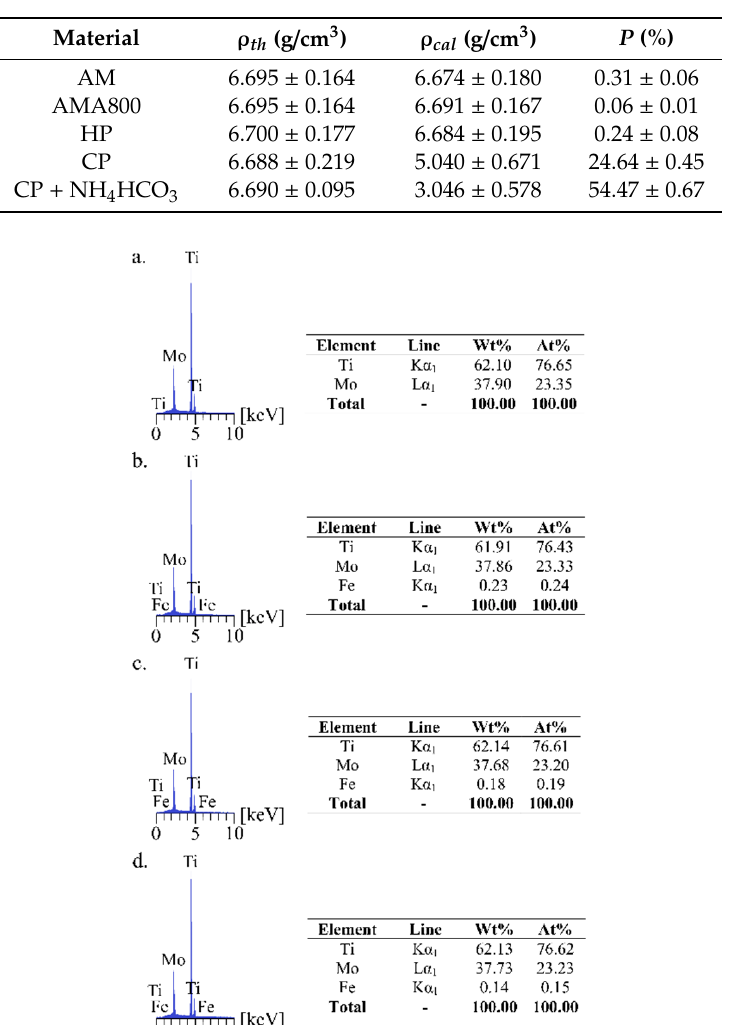
Table 2. Theoretical density ( ρ th ), calculated density ( ρ cal ), and porosity ( P ) of Ti23Mo alloy obtained by different processing approach.